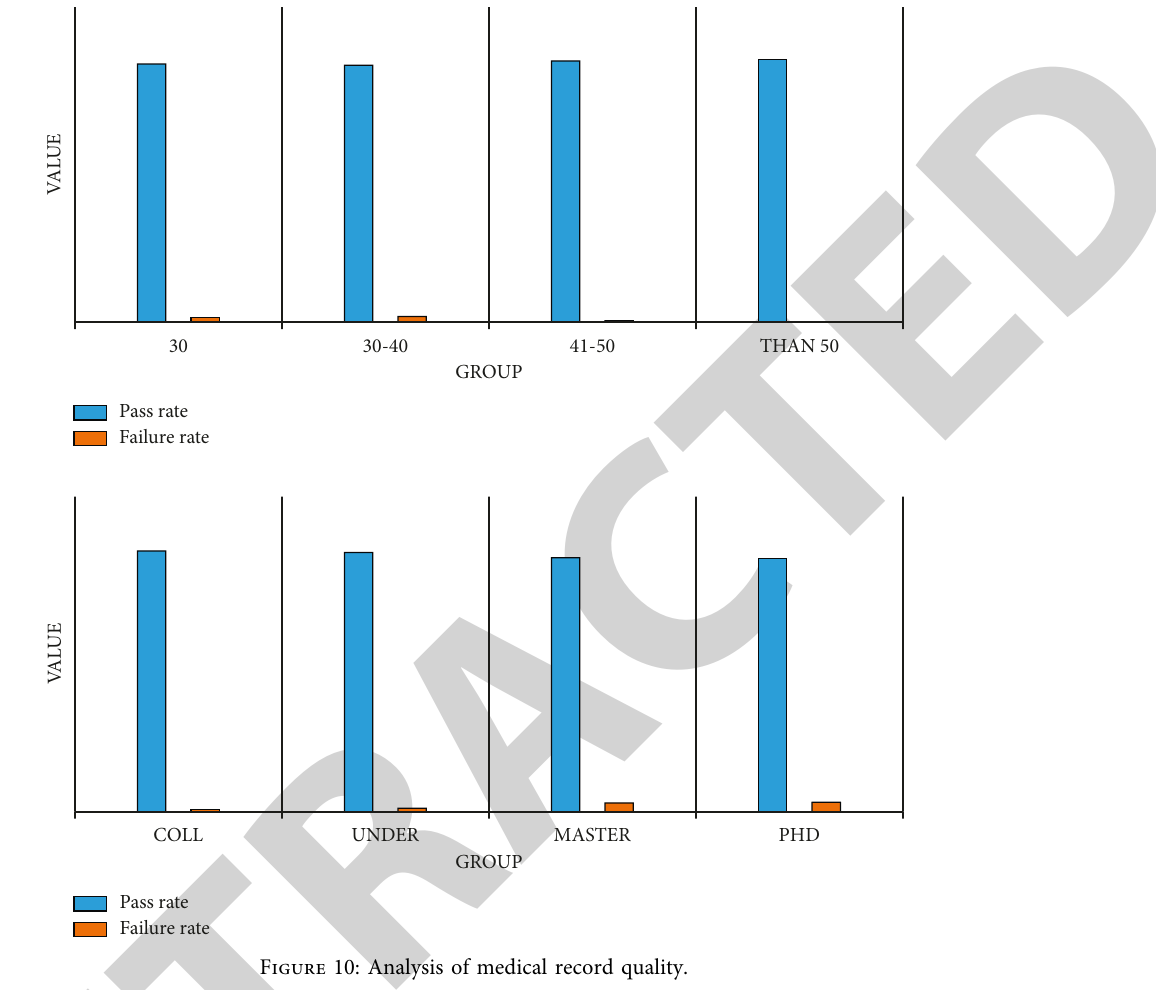
Figure 10: Analysis of medical record